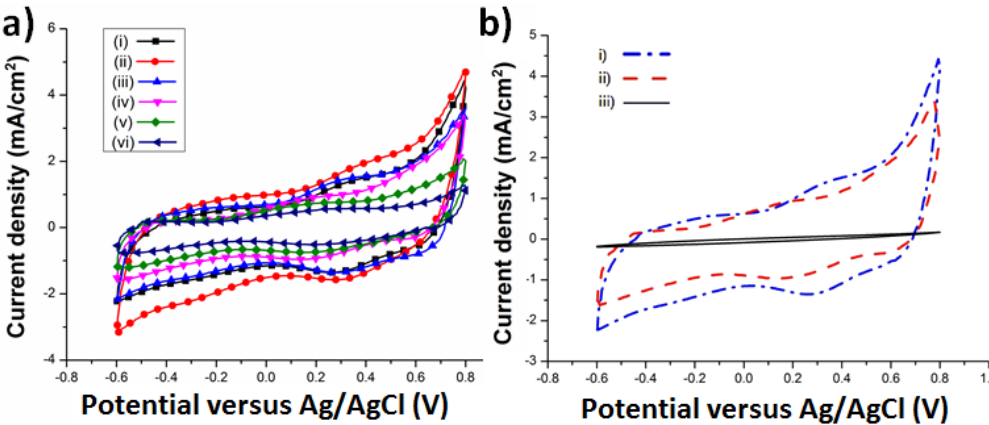
Figure 4. Cyclic voltammograms of ( a ) as-deposited IrO x /Pt composite films with IrO x /Pt ratio of (i) 300/0, (ii) 200/100, (iii) 100/200; and annealed IrO x /Pt composite films with IrO x /Pt ratio of (iv) 300/0, (v) 200/100, (vi) 100/200; ( b ) charge storage capacity (CSC) comparison of (i) as-deposited IrO x film,